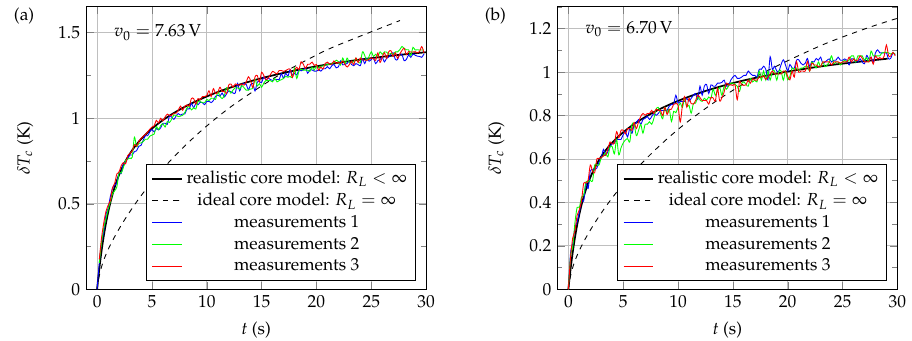
Figure 14. Evolution of the active core temperature δ T c ( t ) = T c ( t ) − T 0 as a function of time t when the self-heated thermistor NTC1 is immersed with zero immersion length ( L i = 0.0 mm) in pure glycerol at rest, considering a working temperature T 0 = 25.0 ◦ C and constant excitation voltages ( a ) v 0 = 7.63V and ( b ) v 0 = 6.70V. Measurements were conducted using the control circuit of Figure